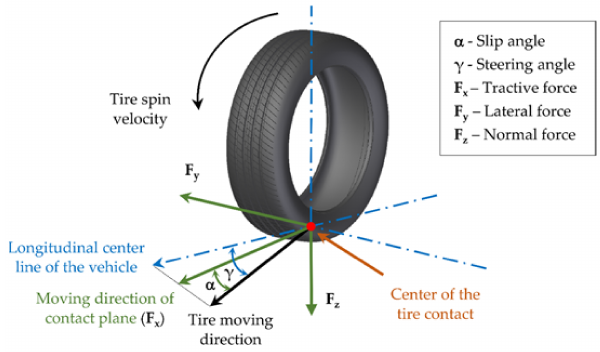
Figure 2. Tire slip angle and steering